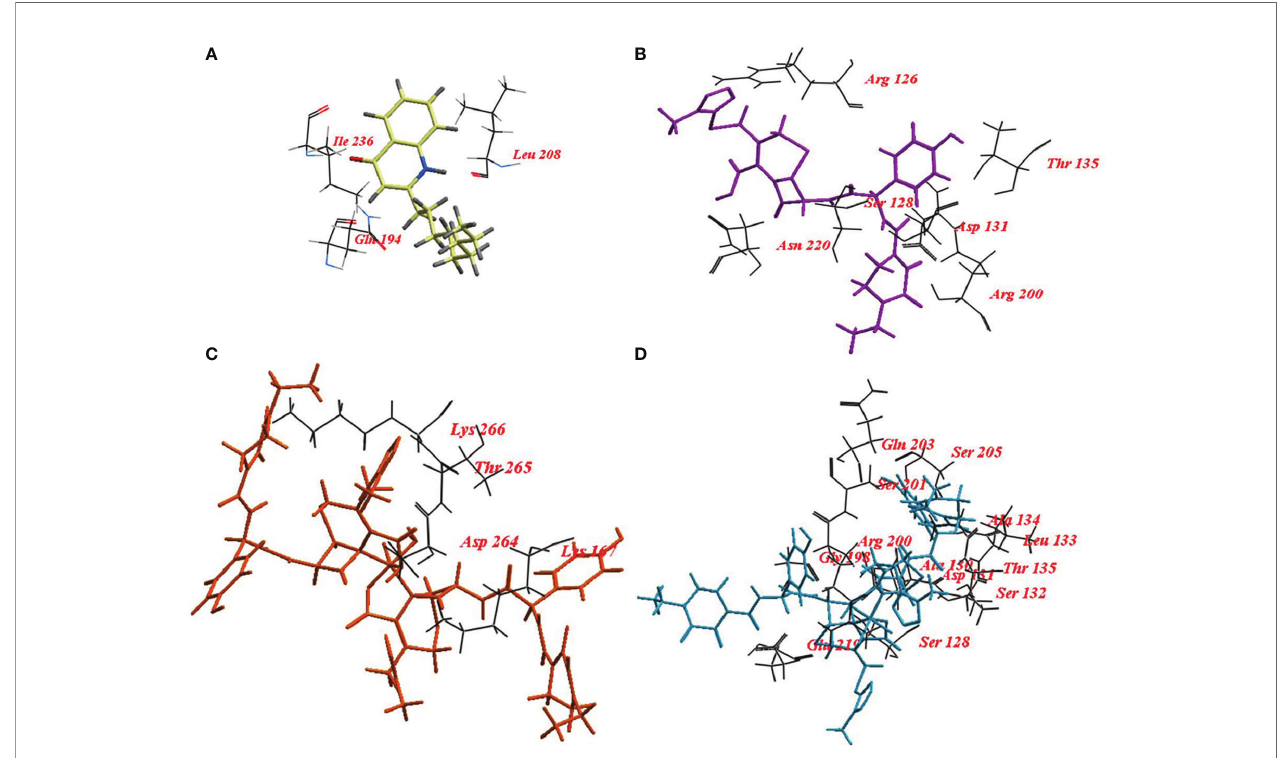
FIGURE 8 | Binding mode of (A) 2-nonyl-4-hydroxyquinoline (NHQ) redocked ligand; (B) Cefoperazone (CFP); (C) , Cefoperazone-Cobalt complex (CFPC) and (D) Cefoperazone-Iron complex (CFPF) into the Crystal structure of PqsR coinducer binding domain of P. aeruginosa